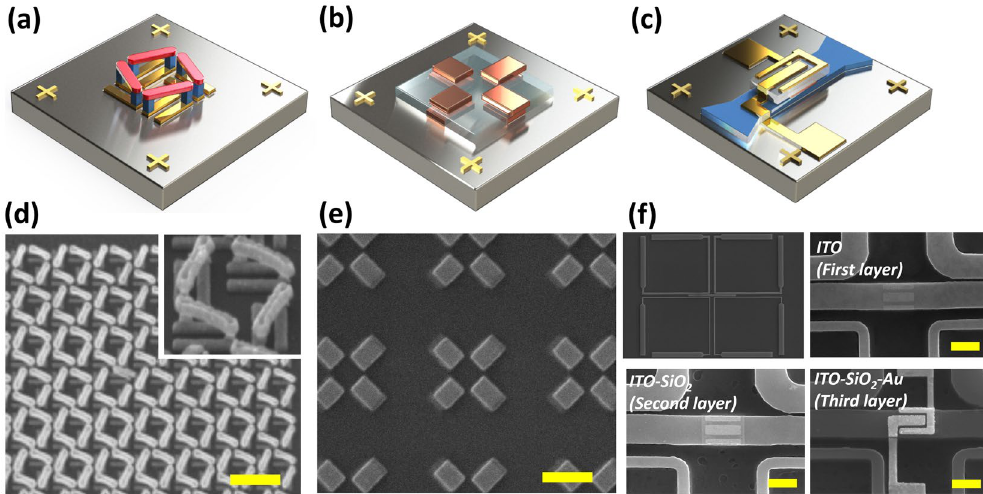
Figure 5. Fabricated 3D nanostructures realized with the proposed EBL overlay process. Suspended/ connected, interlayered and hierarchical 3D nanostructures or nanodevices are shown. ( a ) 3D suspended and connected chiral nanostructure which is composed of Au. Upper bars are supported by the middle pillars. ( b ) 3D interlayered toroidal nanostructure for an artificial toroidal dipole response at NIR. Au is used for the nanostructures and SiO 2 is used for spacer. ( c ) 3D hierarchical structured waveguide device. On top of the waveguide, three metal-oxide-semiconductor (Au-SiO 2 -Indium tin oxide (ITO)) structures are stacked. Applying a voltage at different parts of the gold electrodes, ITO charge concentrations are changed and specific electric field propagating the waveguide are absorbed. (See the section 3 in Supplementary Information) ( d – f ) SEM images of the corresponding 3D nanostructures demonstrated with less than 20 nm misalignment. All scale bars represent 500